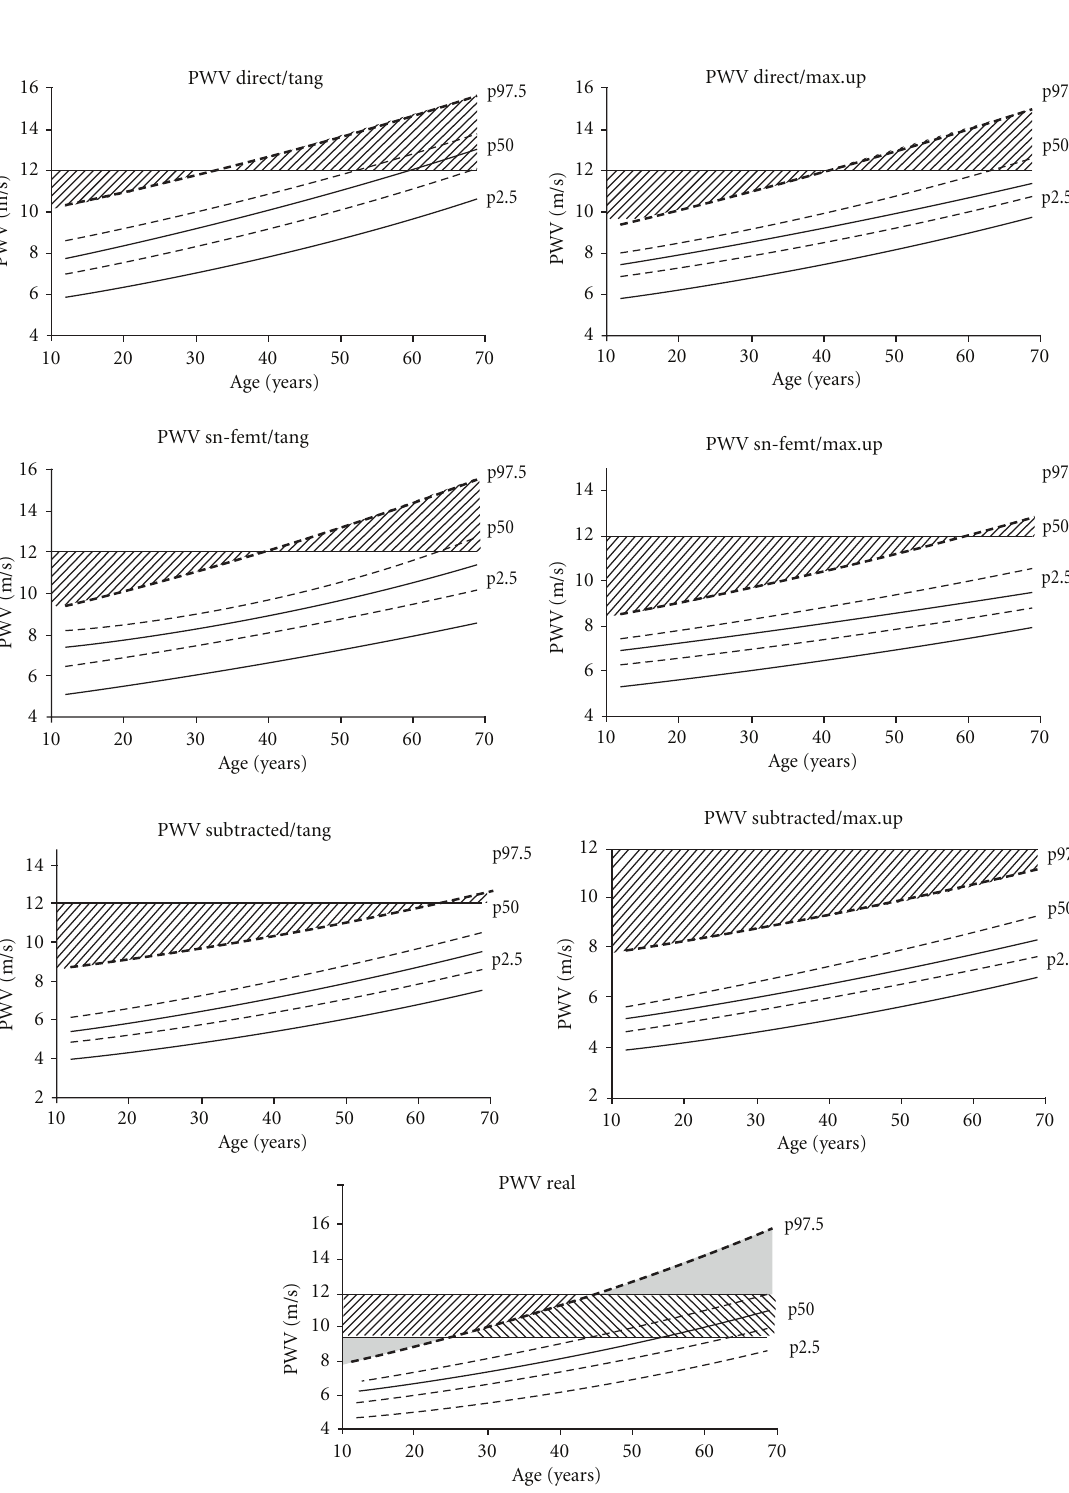
Figure 2: PWV nomograms for the reference population with percentiles (p) 97.5, 50, and 2.5. Broken lines indicate mean confidence interval. The dashed areas illustrate di ff erences between the threshold defined from our population and the fixed unique threshold proposed in the ESH/ESC Guidelines. For PWV Real the fixed unique threshold proposed by Boutouyrie et al. (9.6m/s) was included [3]. Note that the fixed threshold of PWV = 12 m/s or 9.6 m/s determines an underestimation and overestimation to detect preclinical arterial wall damage in young and old subjects, respectively. Underestimation or overestimation would di ff er depending on the subjects’ age and the algorithm used to assess